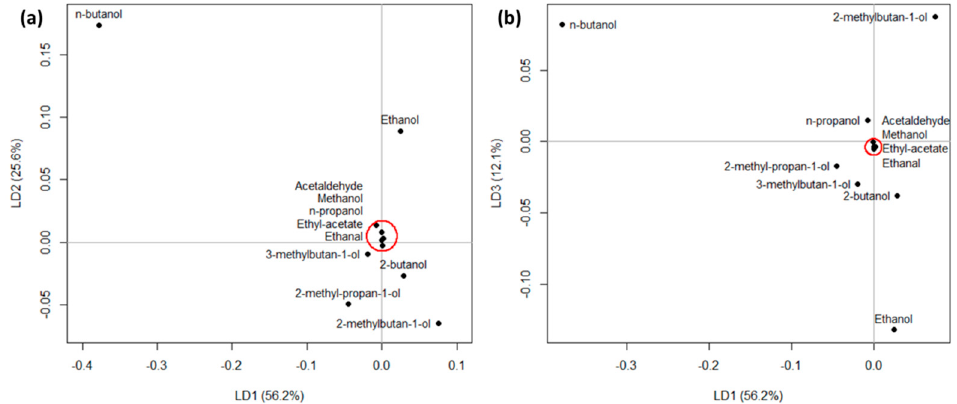
Figure 3. LDA-loadings plots for ( a ) LD1 vs. LD2; ( b ) LD1 vs. LD3. The names of the molecules inside the red circles are reported outside the circles.